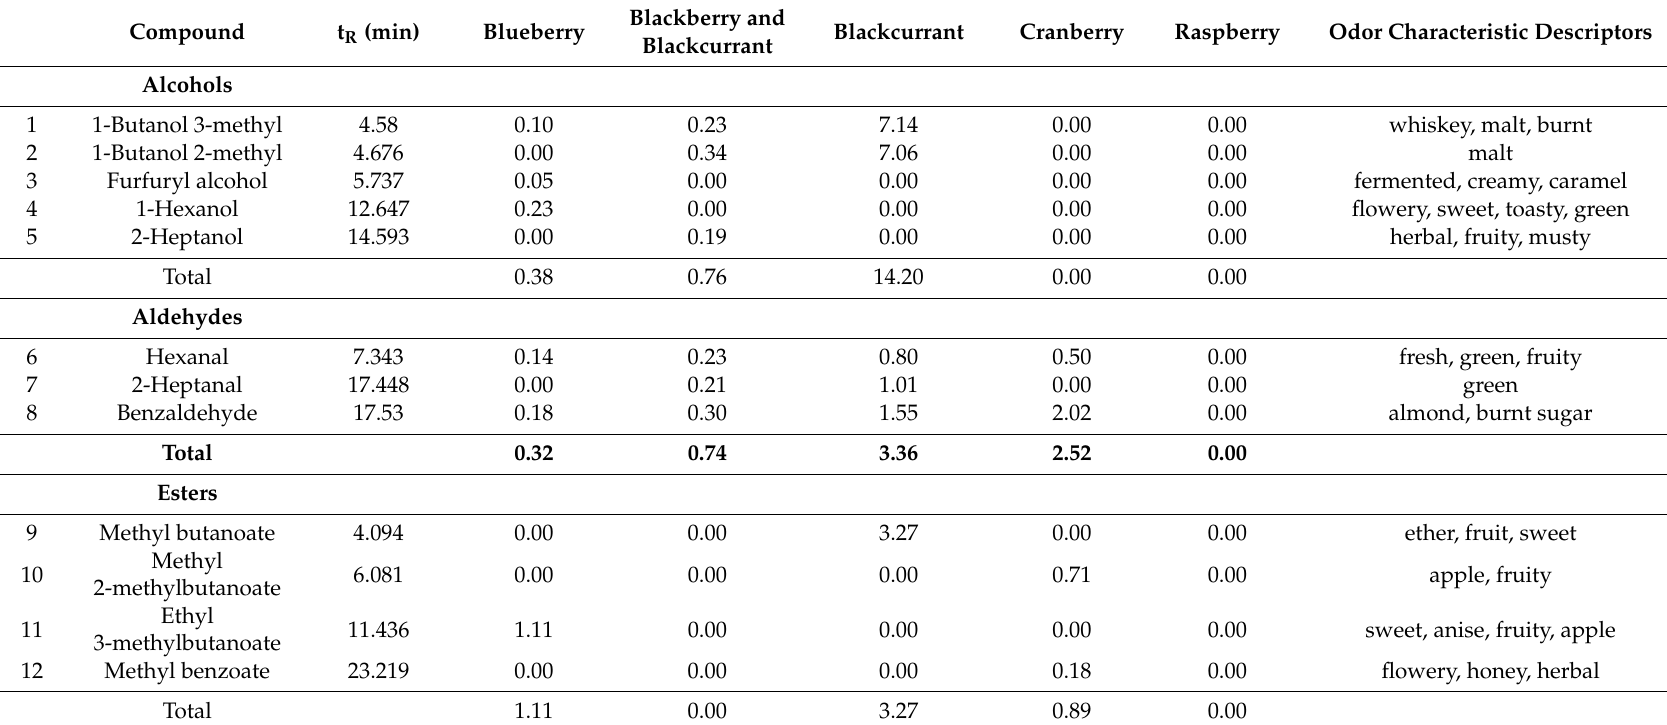
Table 4. Relative percentage (% of total peaks area) of volatile compounds found in berry